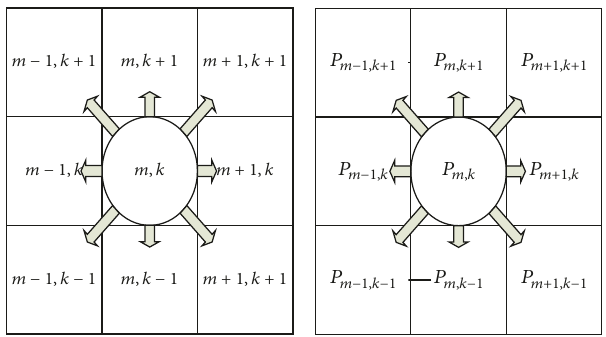
Figure 2: The scheme of Moore’s